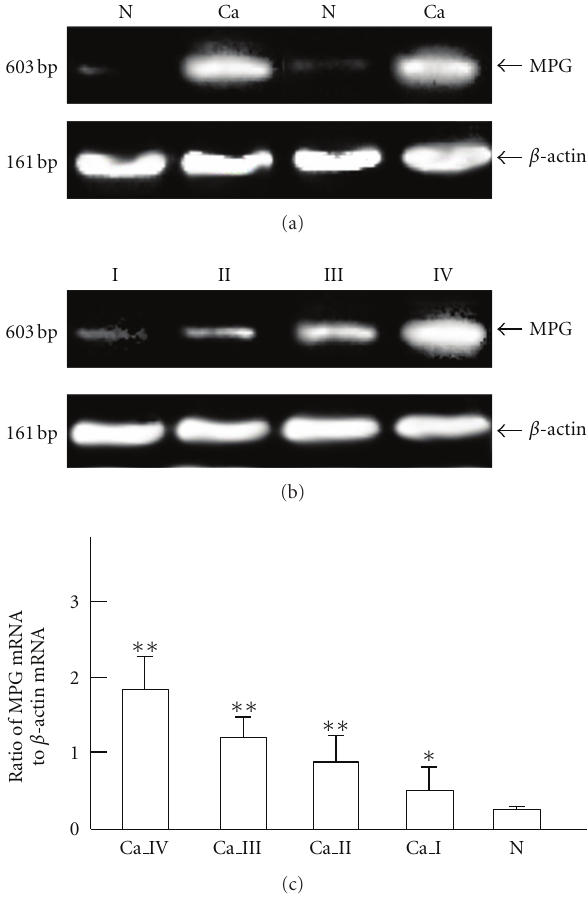
Figure 2: Expression of MPG gene in glioma and nonneoplastic brain tissues by quantitative real-time PCR analysis. (a) MPG gene expression levels in glioma (lanes 2 and 4) and nonneoplastic brain tissues (lanes 1 and 3). (b) MPG gene expression levels in glioma with di ff erent WHO grades. Lanes 1 to 4: MPG gene expression in glioma tissues with WHO grade I, II, III, and IV, respectively. (c) MPG gene expression levels in nonneoplastic brain tissues and glioma with di ff erent WHO grades. “N” refers to nonneoplastic brain tissues; “Ca” refers to glioma tissues; “Ca I” ∼ “Ca IV” refer to glioma tissues with WHO grade I ∼ IV. β -actin was used as an internal control for quantitative real-time PCR analysis. Values are means ± SD. ∗ P < 0 . 05, comparison with nonneoplastic brain tissues; ∗∗ P < 0 . 001, comparison with nonneoplastic brain